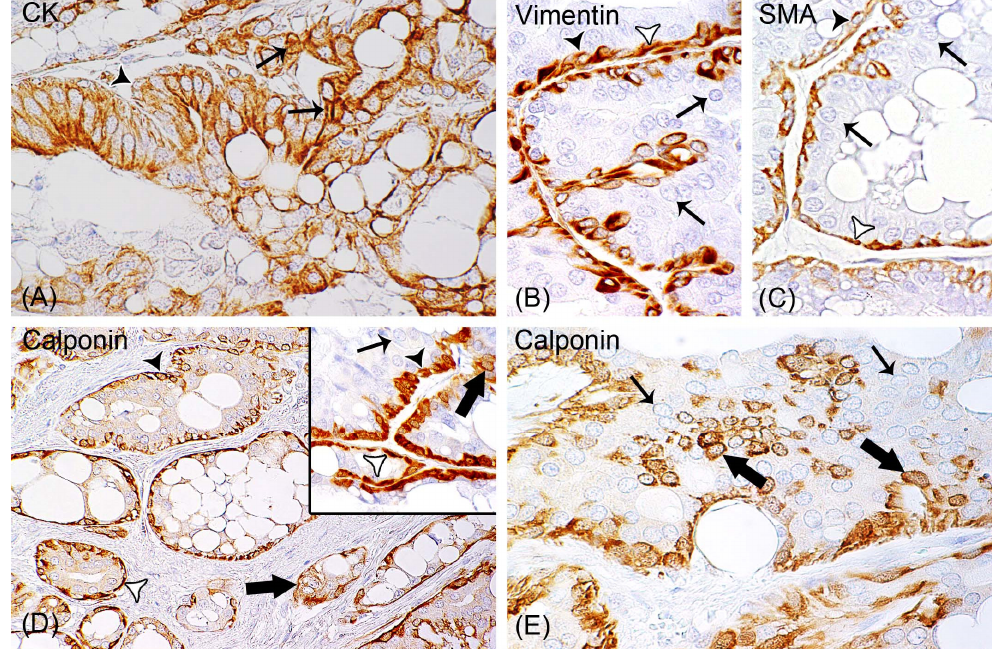
Figure 3. Immunohistochemistry confirming that all rabbit mammary adenocarcinomas contain areas with non-neoplastic myoepithelial cells (ME cells) and areas of invasive carcinoma. In 115/119 (93%) of the tumors, 1.62% to 22% of tumor cells are calponin-positive. ( A ) Tumor cells (thin arrows) and retained ME cells (black arrowhead) are positive for cytokeratin AE1/AE3, with 3.3´-diaminobenzidine tetrahydrochloride (DAB) used as chromogen. ( B , C ) Vimentin and smooth muscle actin staining of ME cells that are spindle-shaped (white arrowhead) or cuboidal to polygonal (black arrowhead). Tumor cells are labelled by thin arrows. ( D ) In addition to ME cells (white and black arrowheads), 93% of the carcinomas contain calponin-positive tumor cells (thick arrows). Inset: Depicted in higher magnification are spindle-shaped (black arrowhead) and hypertrophic (white arrowhead) ME cells, calponin-positive tumor cells (thick arrow), and remaining tumor cells (thin arrow). ( E ) Calponin-positive tumor cells (thick arrows) are mixed with calponin-negative carcinoma cells (thin arrows).